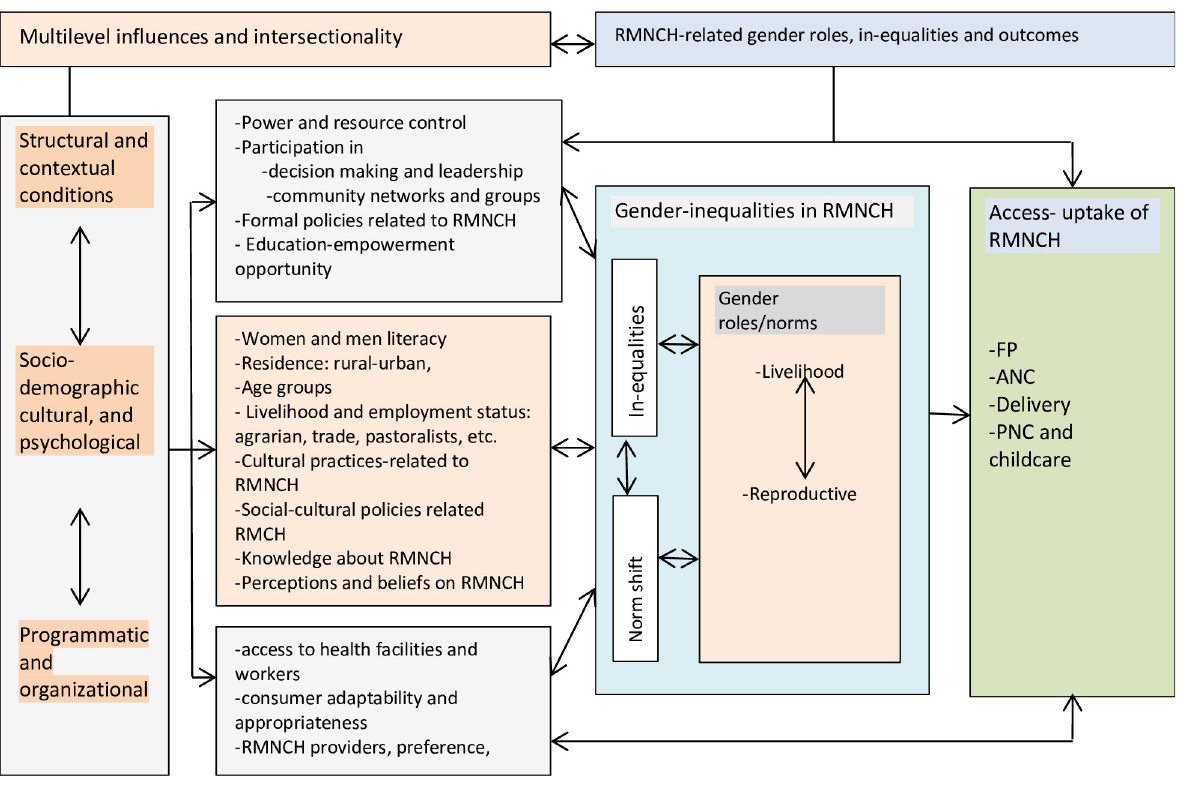
Fig 1. Diagram indicating gender intersectionality in shaping access-use of RMNCH developing regions of Ethiopia Note: Reciprocal arrows indicated intersectionality across barriers-facilitators conditions of access-use of RMNCH.